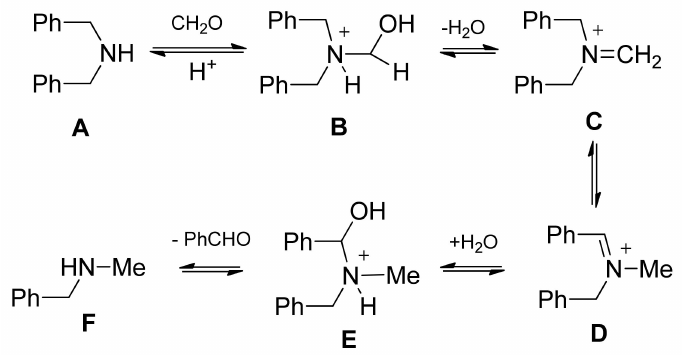
Scheme 5. Proposed substituent exchange under Mannich condensation of dibenzylamine.